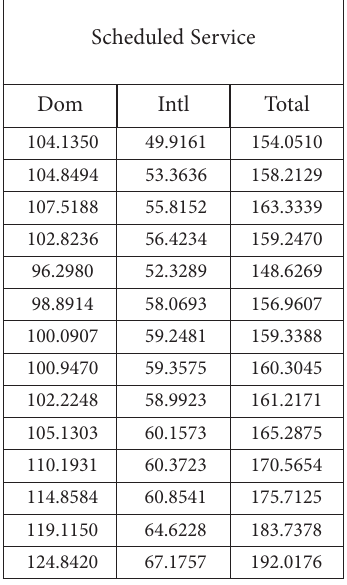
Table 3. Revenue Tonne-kilometres (RTKs x 10 9 ) for U.S. air carriers on an annual